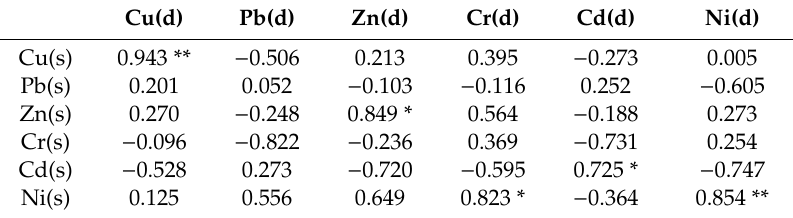
Table 4. Correlation coe ffi cients of heavy metals in dustfull and